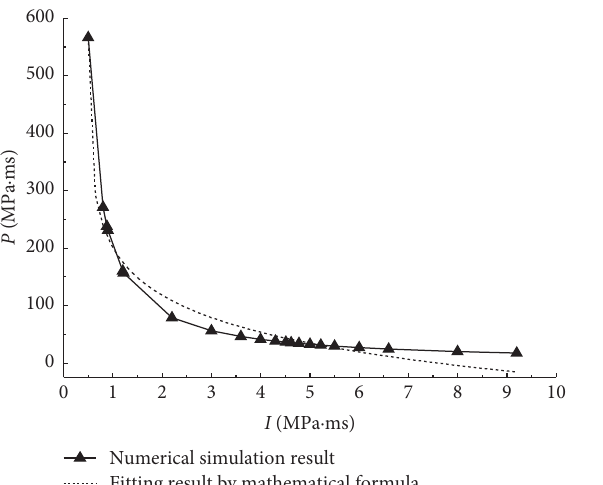
Figure 23: Comparison between fit pressure-impulse (P-I) curve and numerical simulation for the NSS CFST